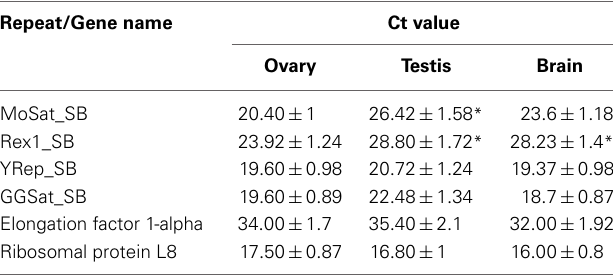
Table 3 | Comparison of the levels (Ct) of repeat-derived transcripts from the gonad and brain of five male and five female adult Asian seabass individuals detected differential expression of MoSat_SB and Rex1_SB between the testis and